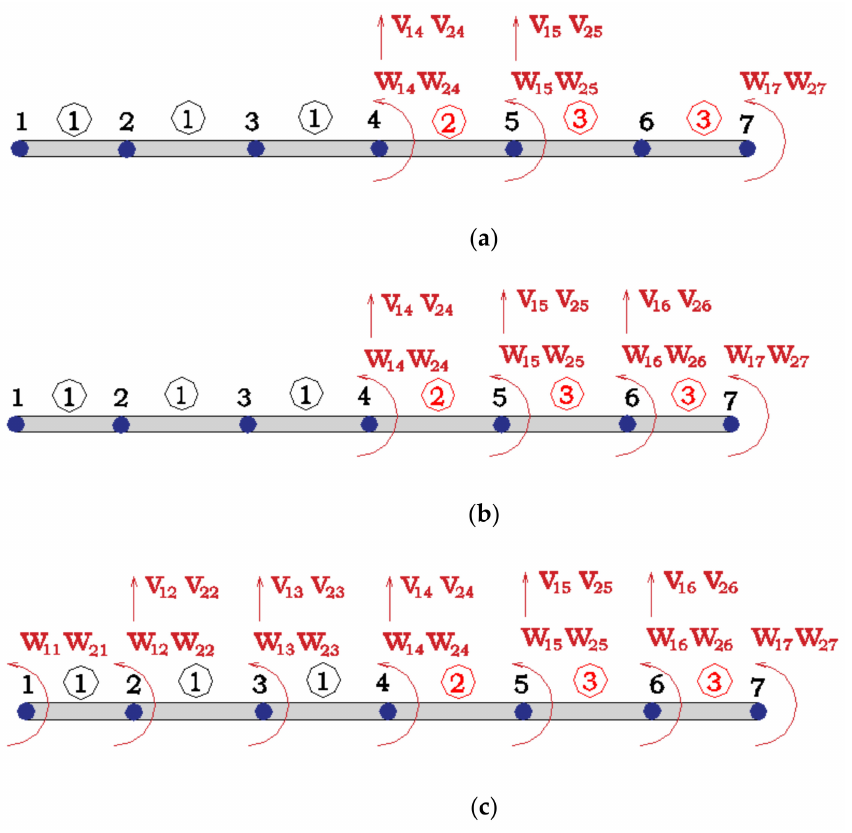
Figure 5. ( a ) Measurement Set A; ( b ) Measurement Set B; ( c ) Measurement Set